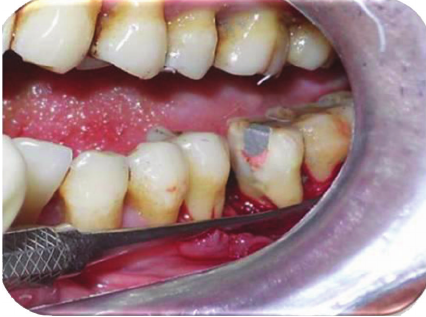
Figure 3: Hemisection of mesial root.